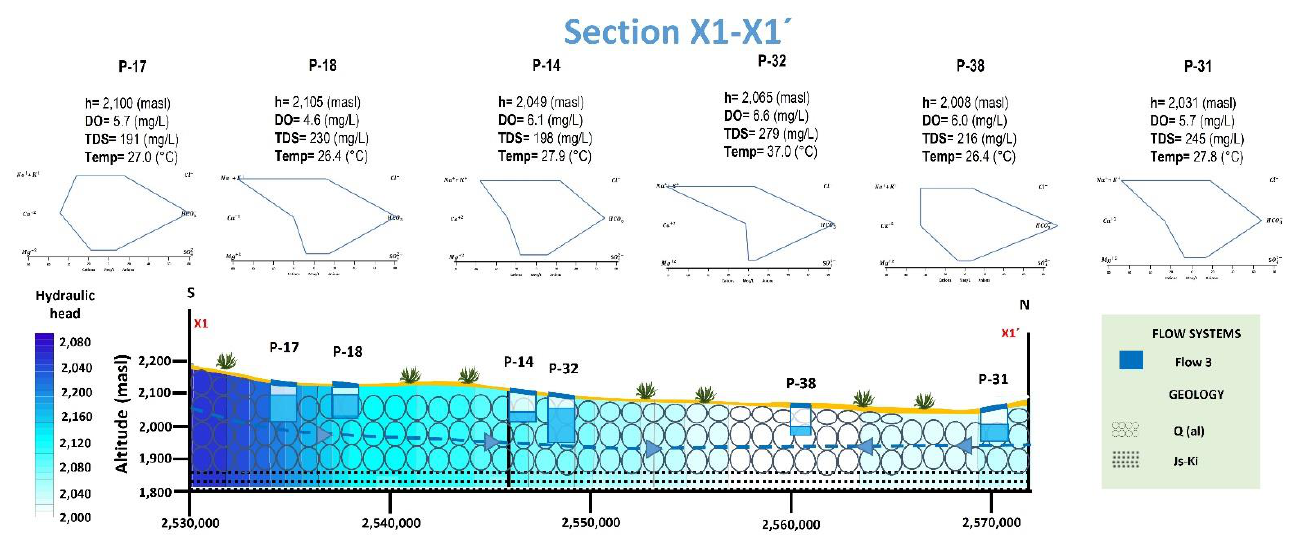
Figure 7. Hydrogeological cross section X1–X1 (cid:48) .